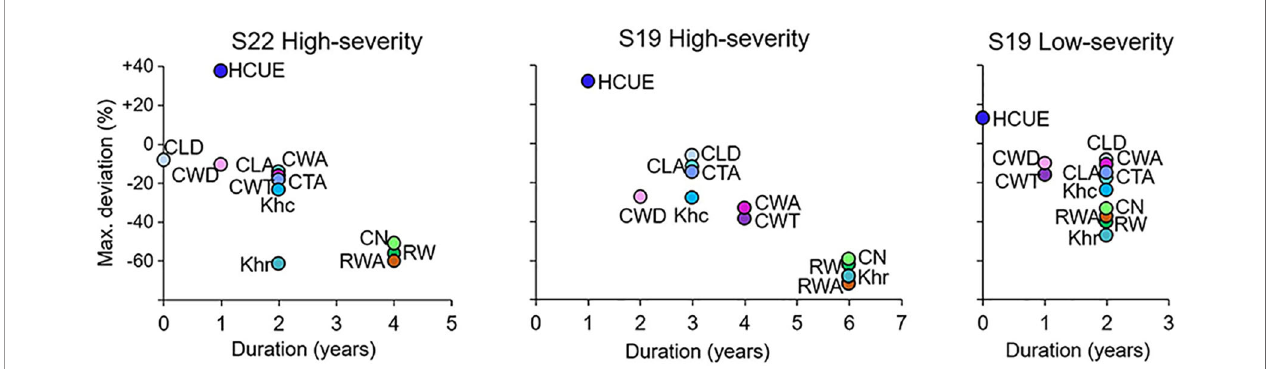
FIGURE 3 | Scatterplot of the duration and maximum deviation of LBM outbreaks on larch xylem anatomical parameters. Parameters are: mean cell lumen radial diameter (CLD), mean cell-wall thickness (CWT), mean cell lumen area (CLA), mean cell-wall area (CWA), mean cell total area (CTA), mean theoretical hydraulic cell conductivity (Kh c ), mean relative anatomical cell wood density (CWD), ring wall area (RWA), theoretical tree-ring hydraulic conductivity (Kh r ), hydraulic carbon use ef fi ciency (HCUE), ring cell number (CN), and ring width (RW). Maximum deviation is the percentage variation of the mean value of the parameter from the reference, i.e. the mean value in the fi ve years before the outbreak, during the year of maximum reduction for an outbreak event. Duration corresponds to the number of years when the parameter was statistically different from the reference, according to Welch ’ s t-test. Deviations and durations are merged for the four high-severity and the four low- severity outbreaks, and for S19 and S22, separately. Parameters for low-severity years for larch at S22 are not presented since deviations were not signi fi